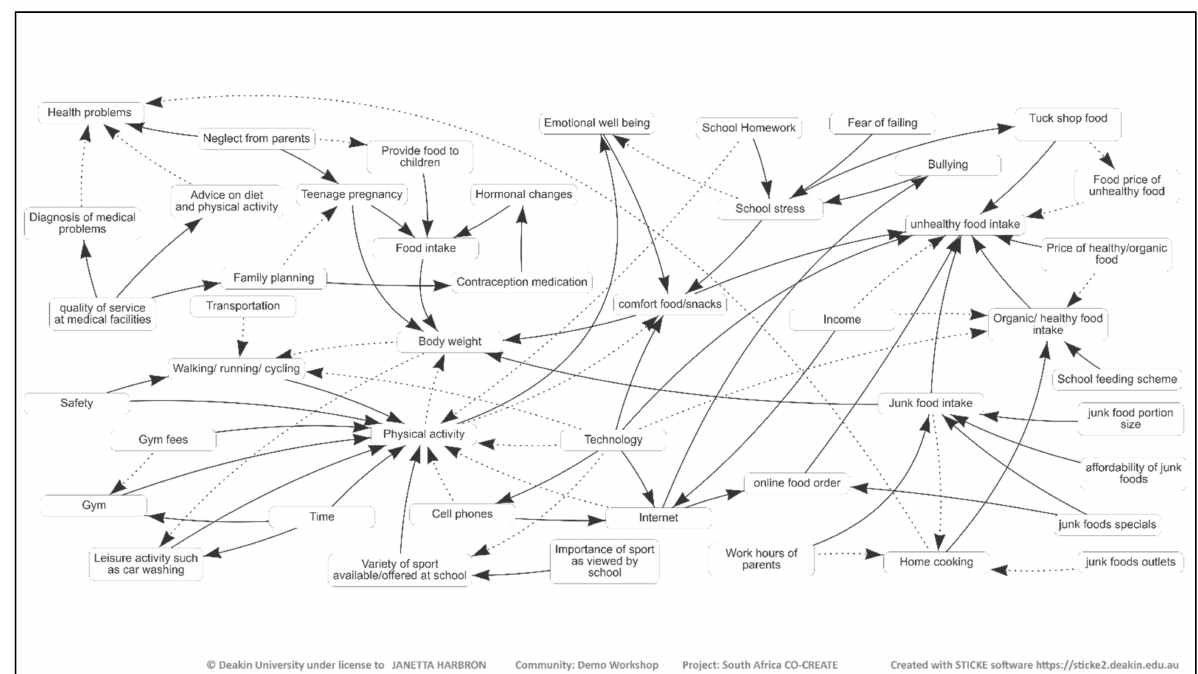
Figure A1. School map